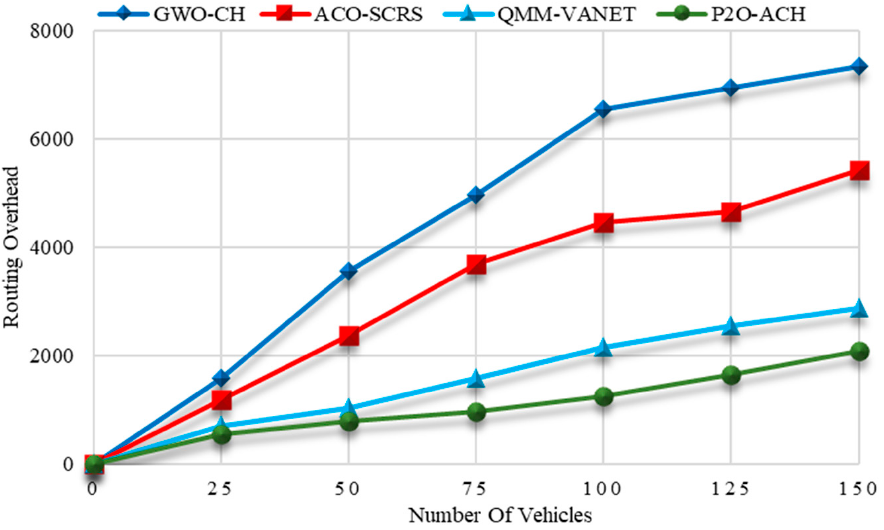
Figure 8. Routing Overhead Calculation.